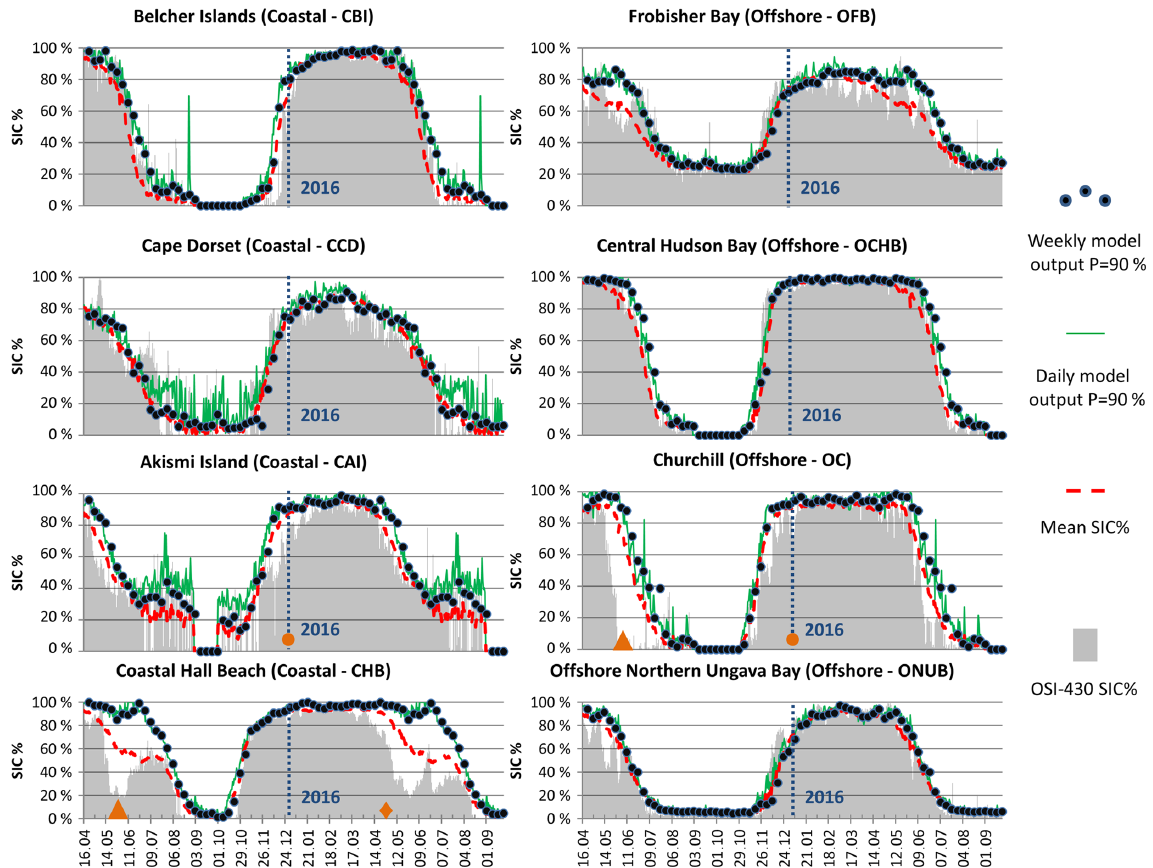
Figure 6. IcePAC weekly and daily P = 90% outputs (i.e. it represents a value of SIC% for which there is a 90% probability that it is equal to or lower than the given SIC% level) versus OSI-430 SIC% observations for the 2015–2016 sea ice season. Some anomalies of various intensities can be detected in the series such as early 2015 melt-out events at Hall Beach and Churchill ( (cid:77) ), late 2016 freeze-up events at Akismi Island and Churchill ( ◦ ), and an early 2016 melt-out event at Hall Beach ( ♦ ).